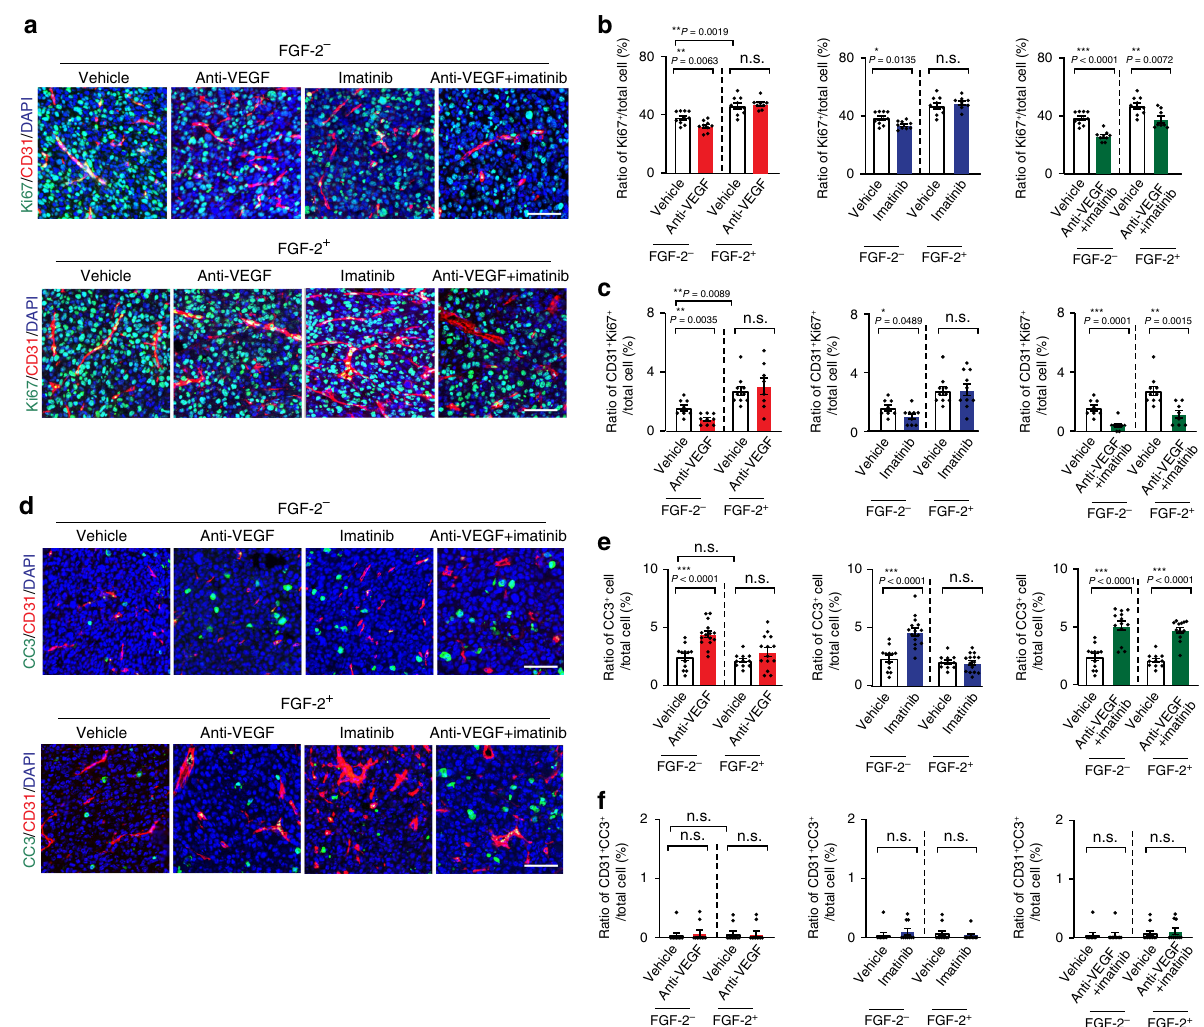
Fig. 3 Tumor cell proliferation and apoptosis of FGF-2 breast cancers in response to various drug treatment. a Ki67 + proliferative cell signals (green) co-stained with CD31 + microvessels (red) and DAPI (blue) of various monotherapy and combination therapy-treated E0771-vector and E0771-FGF-2 breast cancer tissues. Bar = 50 μ m. b Quanti fi cation of Ki67 + signals in vehicle-, anti-VEGF-, imatinib- and combination therapy-treated E0771-vector and E0771-FGF-2 breast cancers ( n (Vector) = 10/9/9/9; n(FGF-2) = 10/8/8/8; P (Vector vs FGF-2) = 0.0019; P (Vehicle-treated vector vs anti-VEGF-treated vector) = 0.0063; P (Vehicle-treated vector vs imatinib-treated vector) = 0.0135; P (Vehicle-treated vector vs the combination therapy-treated vector) < 0.0001; P (Vehicle-treated FGF-2 vs the combination therapy-treated FGF-2) = 0.0072). c Quanti fi cation of Ki67 + and CD31 + double-positive signals in vehicle-, anti-VEGF-, imatinib- and combination therapy-treated E0771-vector and E0771-FGF-2 breast cancers ( n (Vector) = 8/9/9/9; n(FGF-2) = 10/8/ 10/8; P (Vector vs FGF-2) = 0.0089; P (Vehicle-treated vector vs anti-VEGF-treated vector) = 0.0035; P (Vehicle-treated vector vs imatinib-treated vector) = 0.0489; P (Vehicle-treated vector vs the combination therapy-treated vector) = 0.0001; P (Vehicle-treated FGF-2 vs the combination therapy- treated FGF-2) = 0.0015). d Micrographs of caspase-3 + apoptotic tumor cells (green) co-stained with CD31 + microvessels (red) and DAPI (blue) in various monotherapy- and combination therapy-treated E0771-vector and E0771-FGF-2 breast cancers. Bar = 50 μ m. e Quanti fi cation of caspase-3 + signals in vehicle-, anti-VEGF-, imatinib- and combination therapy-treated E0771-vector and E0771-FGF-2 breast cancers ( n (Vector) = 12/15/15/13; n (FGF-2) = 11/14/15/13;; P (Vehicle-treated vector vs anti-VEGF-treated vector) < 0.0001; P (Vehicle-treated vector vs imatinib-treated vector) < 0.0001; P (Vehicle-treated vector vs combination therapy-treated vector) < 0.0001; P (Vehicle-treated FGF-2 vs combination therapy-treated FGF-2) < 0.0001). f Quanti fi cation of caspase-3 + -CD31 + double-positive signals in vehicle-, anti-VEGF-, imatinib- and combination therapy-treated E0771-vector and E0771- FGF-2 breast cancers ( n (Vector) = 10 each; n(FGF-2) = 10 each). FGF-2 − = vector cancers; FGF-2 + = FGF-2 cancers; n.s. Not signi fi cant; * P < 0.05; ** P < 0.01; *** P < 0.001; two-tailed student t -test. Data presented as mean from random fi elds ± s.e.m. Experiments were independently repeated twice. Source data are provided as a Source Data fi